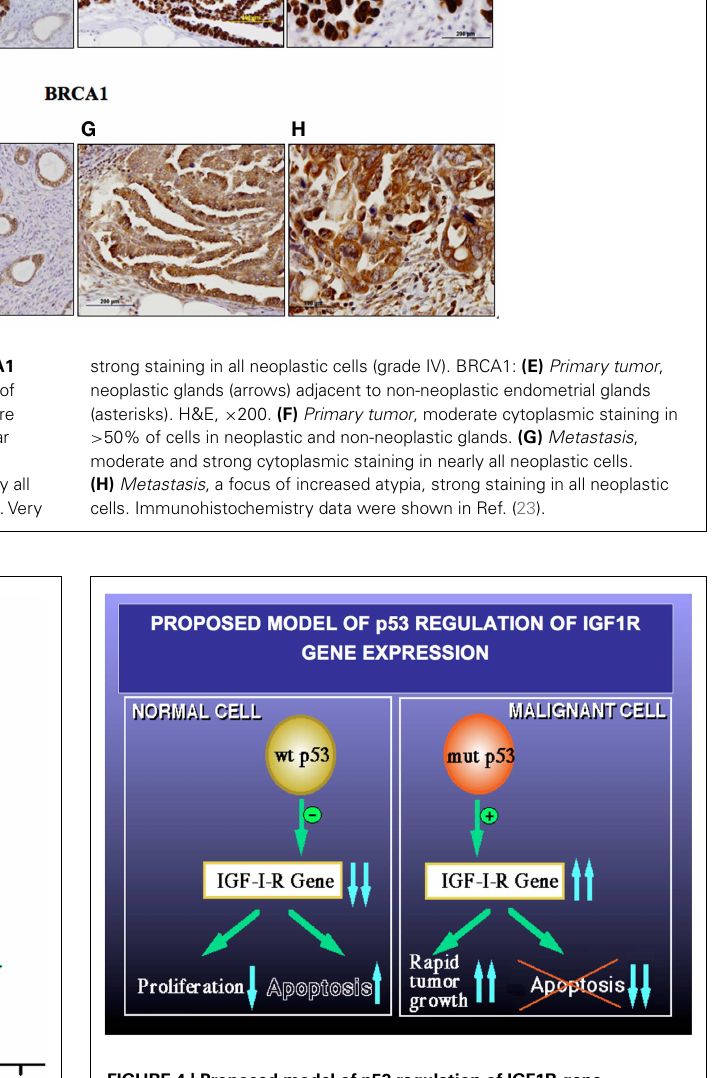
FIGURE 4 | Proposed model of p53 regulation of IGF1R gene expression .Tumor suppressor p53 is a negative cell cycle regulator that prevents passage of damaged DNA to daughter cells.Wild type p53 suppresses IGF1R gene transcription, leading to reduced IGF1R levels and a decrease in IGF1- and IGF2-stimulated IGF1R phosphorylation. As a net result, cell proliferation is reduced and apoptosis is increased (left panel). Loss-of-function or gain-of-function mutations of p53 are common events in cancer (right panel). Mutant forms of p53 are able to transactivate the IGF1R gene, with ensuing increase in IGF1R biosynthesis. Augmented IGF1R expression and activation is a pre-requisite for tumor growth and is usually associated with abrogation of apoptosis (i.e., enhanced cell survival). A similar paradigm applies for